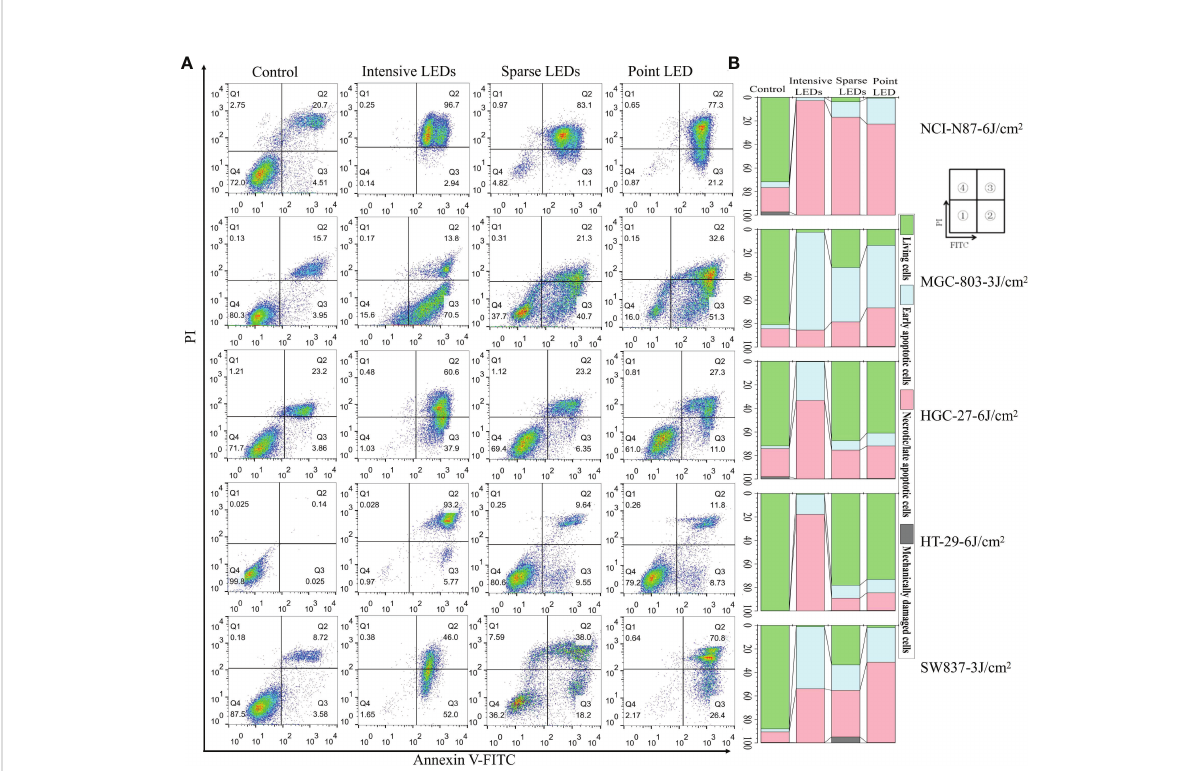
FIGURE 3 Apoptosis of GI cancer cells induced by PDT with different light fi elds. Cells were fi rst irradiated with the intensive LED, sparse LED, and point LED arrays, and then the apoptosis were detected. (A) Apoptosis rate: Cells were stained with annexin-FITC/PI at 12 h post-PDT. Annexin V-FITC and PI stains indicate apoptotic and necrotic cells, respectively. ① Living cells, ② early apoptotic cells, ③ necrotic/late apoptotic cells, and ④ mechanically damaged cells. (B) Percentage stacked bar chart corresponding to (A)